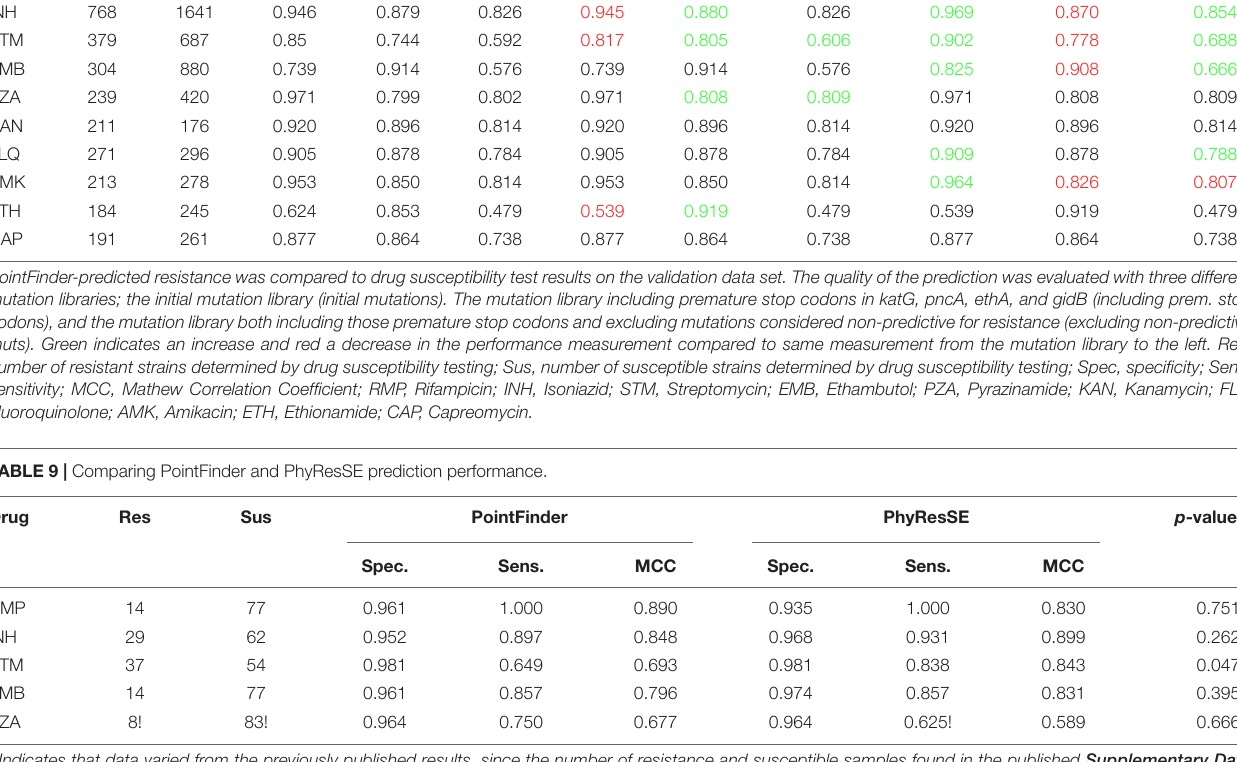
TABLE 8 | Validating the effect of including premature stop codons and excluding non-predictive mutations from the mutation library. Drug Res Sus Initial mutations Including prem. stop codons Excluding non-predictive muts Spec. Sens.